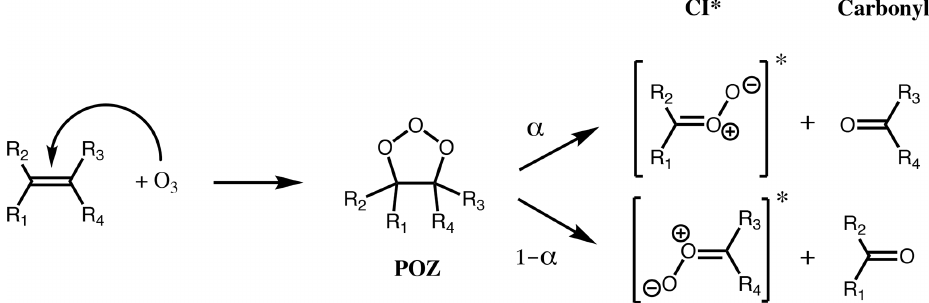
Figure 1. First step of alkene ozonolysis. A primary ozonide (POZ) is formed which rapidly decomposes to yield a pair of chemically activated Criegee intermediates and carbonyl